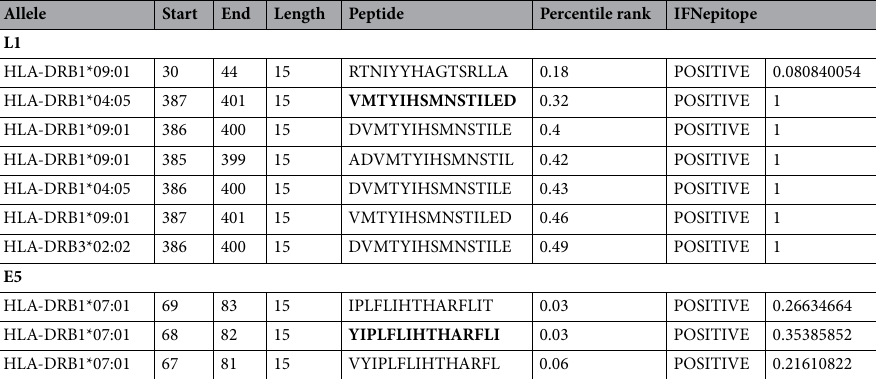
Table 3. MHC-II epitopes of L1 and E5 proteins of HPV 16. Bold text represents the peptides used in vaccine